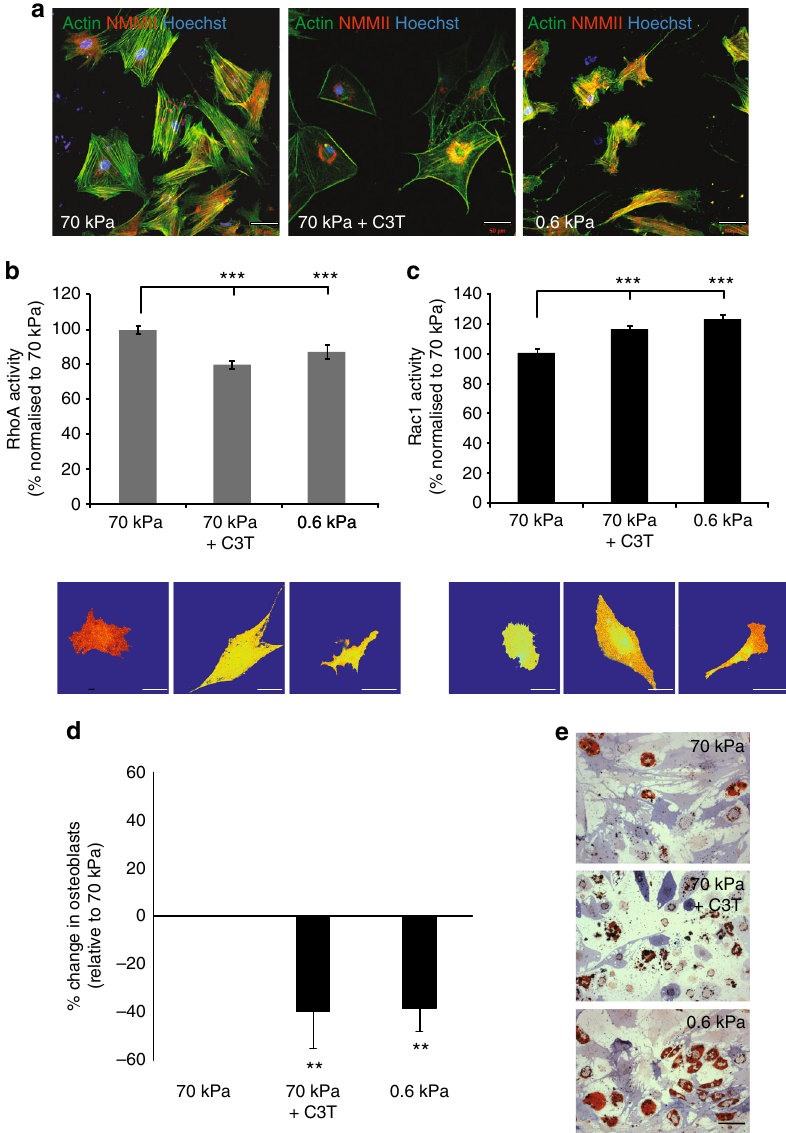
Fig. 1 Characterisation of hMSC properties in response to substrate stiffness and RhoA inhibition. a Morphology of hMSCs showing actin (green), nuclei (blue) and non-muscle myosin II (red). Scale bar, 50 μ m. b RhoA and c Rac1 activity, as determined by FRET biosensor. Data is shown as mean ± SEM for hMSCs from three independent donors ( n > 20/donor) with heatmaps of a representative cell. Scale bar, 50 μ m. d Differentiation switch between osteogenesis and adipogenesis. Graph shows mean percentage change in osteoblasts ± SD for N = 4 MSC donors. e Representative images of alkaline phosphatase (blue) and Oil Red O (red) staining of hMSCs under the three different conditions. Scale bar, 100 μ m. Samples were analysed by one-way ANOVA with Tukey post hoc testing. Statistically different samples are denoted by * p < 0.05, ** p < 0.01 and *** p <